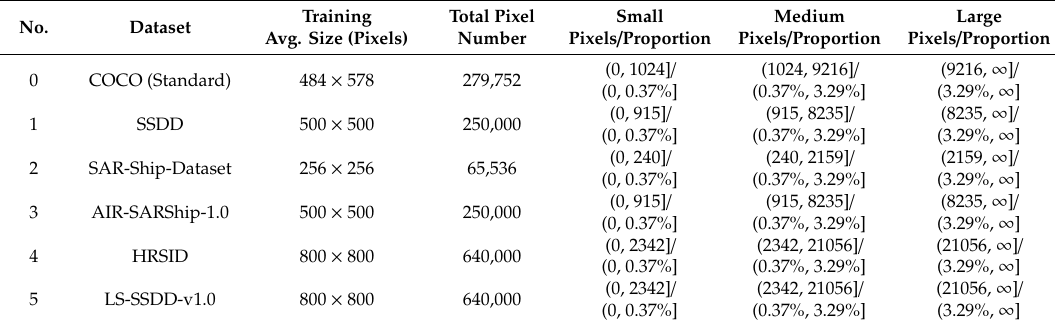
Table 5. The definition standard of ship size in di ff erent